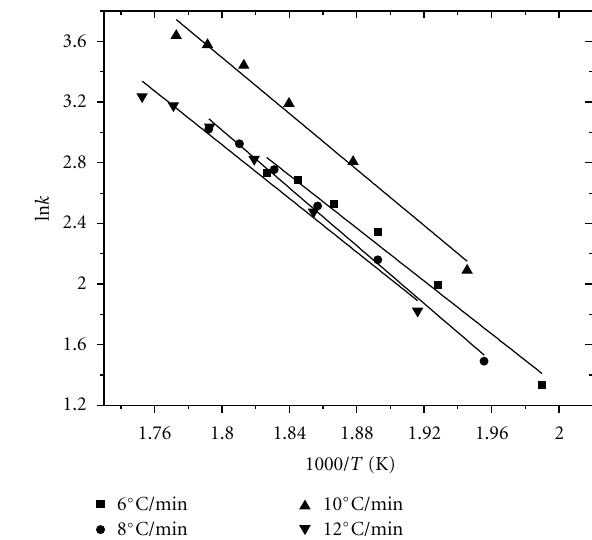
tmhd at different ( ) 4